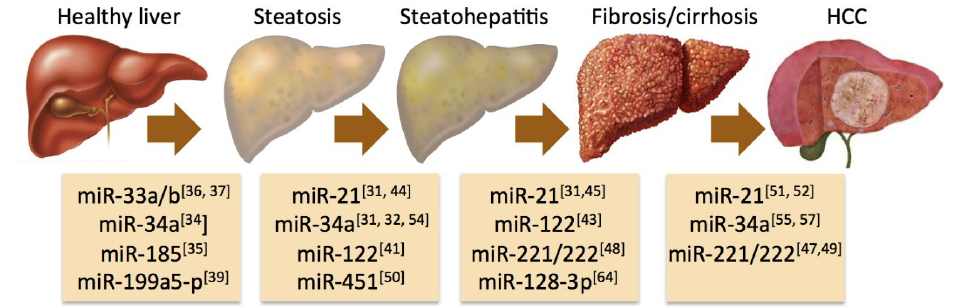
Figure 1. Implication of microRNAs in key transitions of the pathogenesis of nonalcoholic fatty liver disease (NAFLD). Schematic illustration of selected miRNAs shown to have an impact on the natural history of NAFLD with relevant references cited in the review. Please see specific details in the main